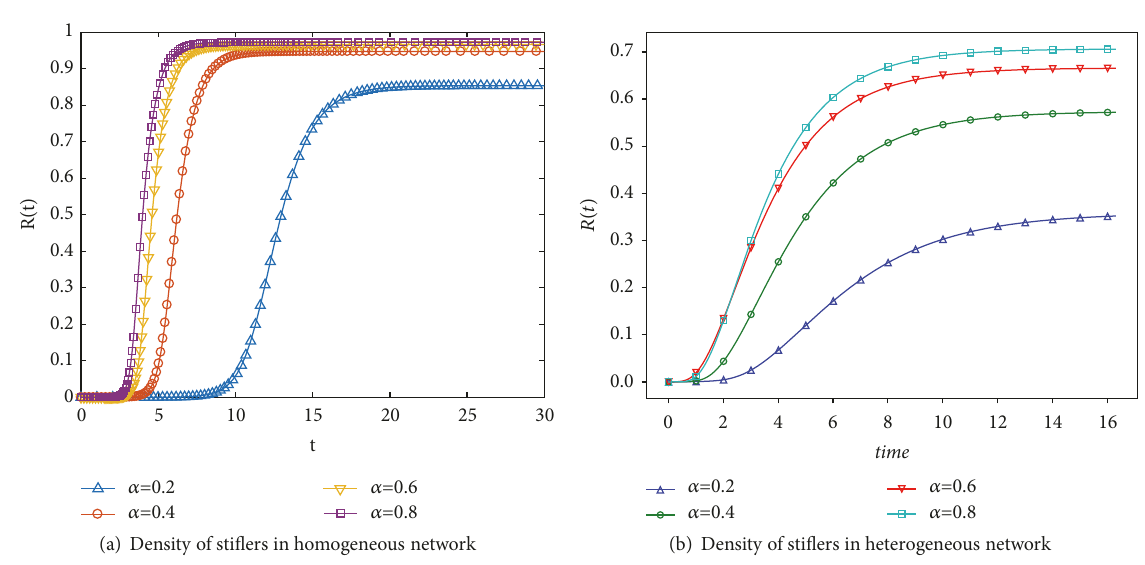
Figure 6: The evolution of stiflers varying over the activity rate 𝛼 with 𝛽 = 0.1 , 𝜆 = 0.5 , and 𝛿 = 0.6 .